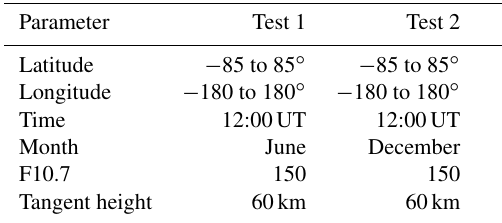
Table 3. Geographic test